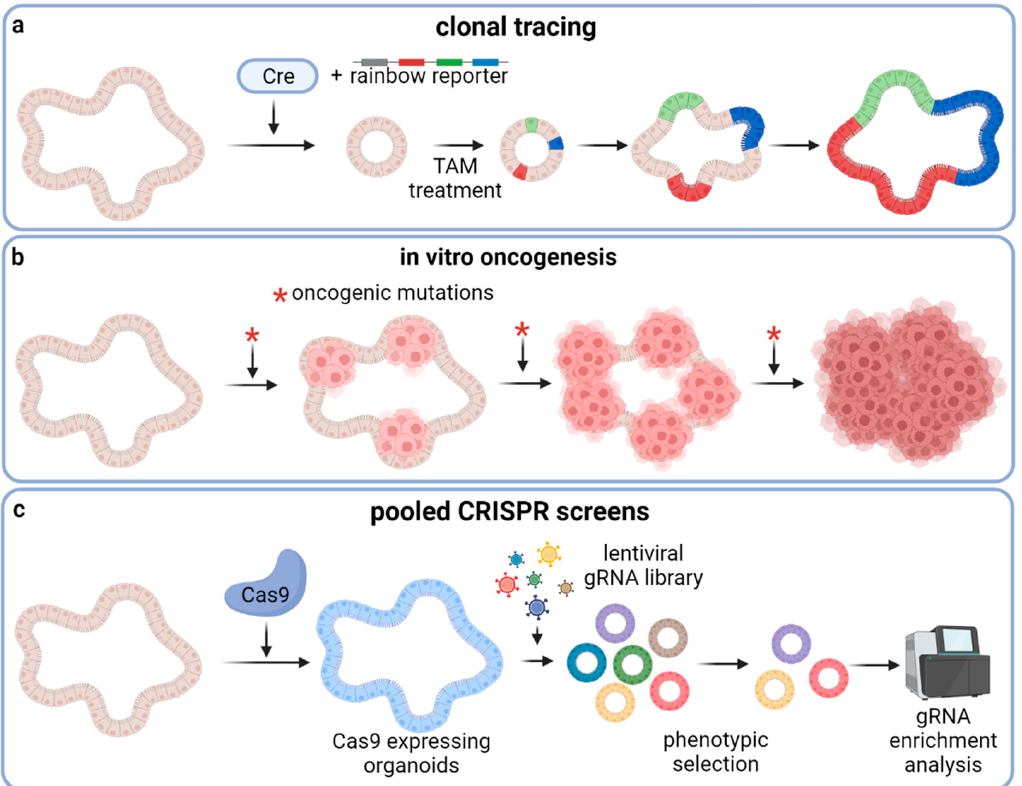
Figure 3. Gene editing applications in organoids. ( a ) Genetic knock-in of a rainbow reporter construct and a Cre-recombinase under the control of a stem-cell-specific promotor enables genetic tagging of individual stem cells and their descendants ( b ) Tumor development can be recapitulated in vitro by introducing oncogenic mutations to normal organoids, for instance by CRISPR/Cas9. Starting with non-malignant organoids, the step-wise addition of oncogenic alterations results in a panel of gradually more malignant organoids, enabling the study of tumorigenesis with its intermediate states. ( c ) Pooled genome-wide lentiviral CRISPR knockout screens in organoids are invaluable tools to identify candidate genes involved in complex biological processes driving carcinogenesis and/or resistance development. *: oncogenic mutations